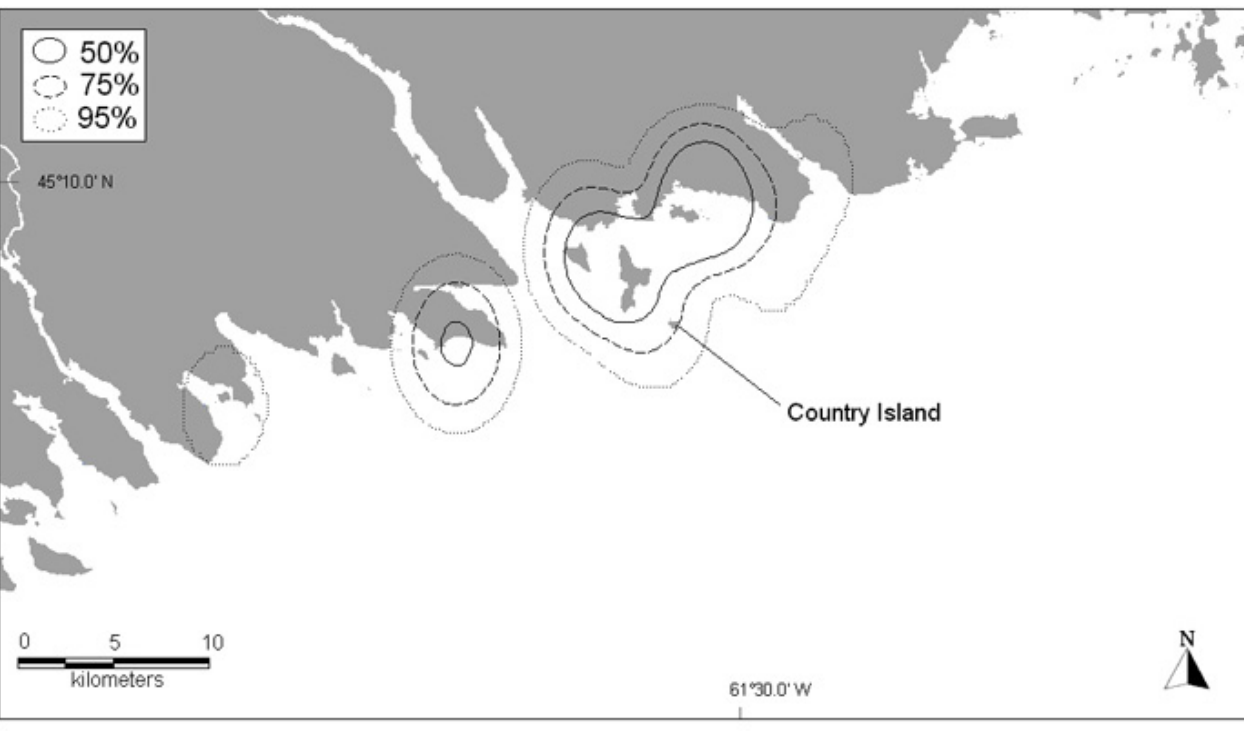
Fig. 2. Density plots from kernel estimations of foraging locations for radio-tagged Roseate Tern nesting on Country Island, Nova Scotia, Canada, in 2003 and 2004. Contours indicate 50, 75, and 95% density